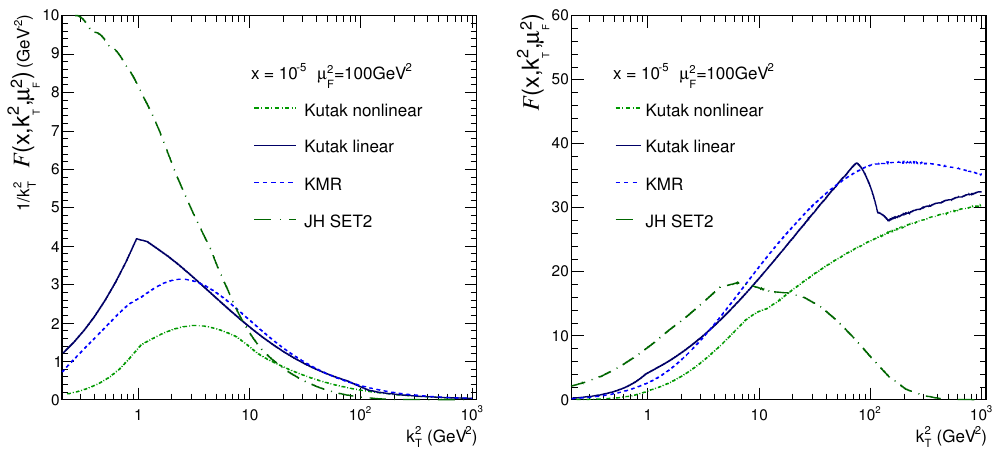
Figure 4 . Unintegrated gluon densities for typical scale (cid:22) 2 = 100 GeV 2 for (cid:17) c (1 S ) production in proton-proton scattering at LHCb